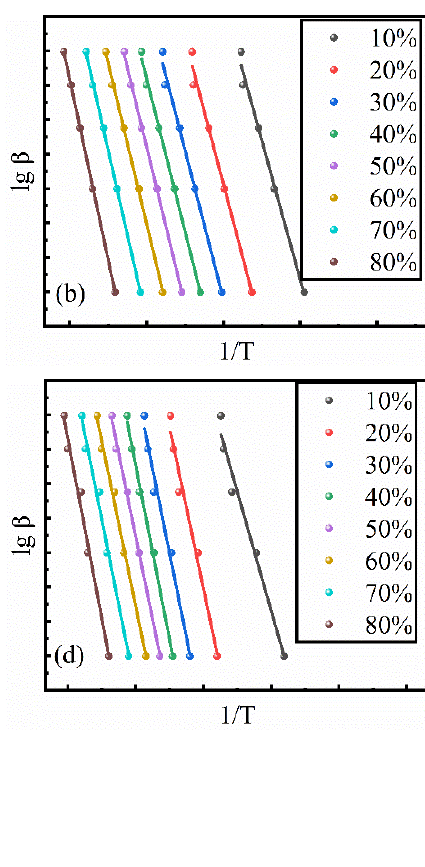
8 of 11 Figure 6. Relationship between ln ( β /Tp) and 1/Tp in thermal degradation. ( a ) EP-(P-M 0%), ( b ) EP- (P-M 10%), ( c ) EP-(P-M 20%), ( d ) EP-(P-M 25%), ( e ) EP-(P-M 30%). Table 1. The thermal degradation kinetic parameters for the Kissinger method. P-M Contents